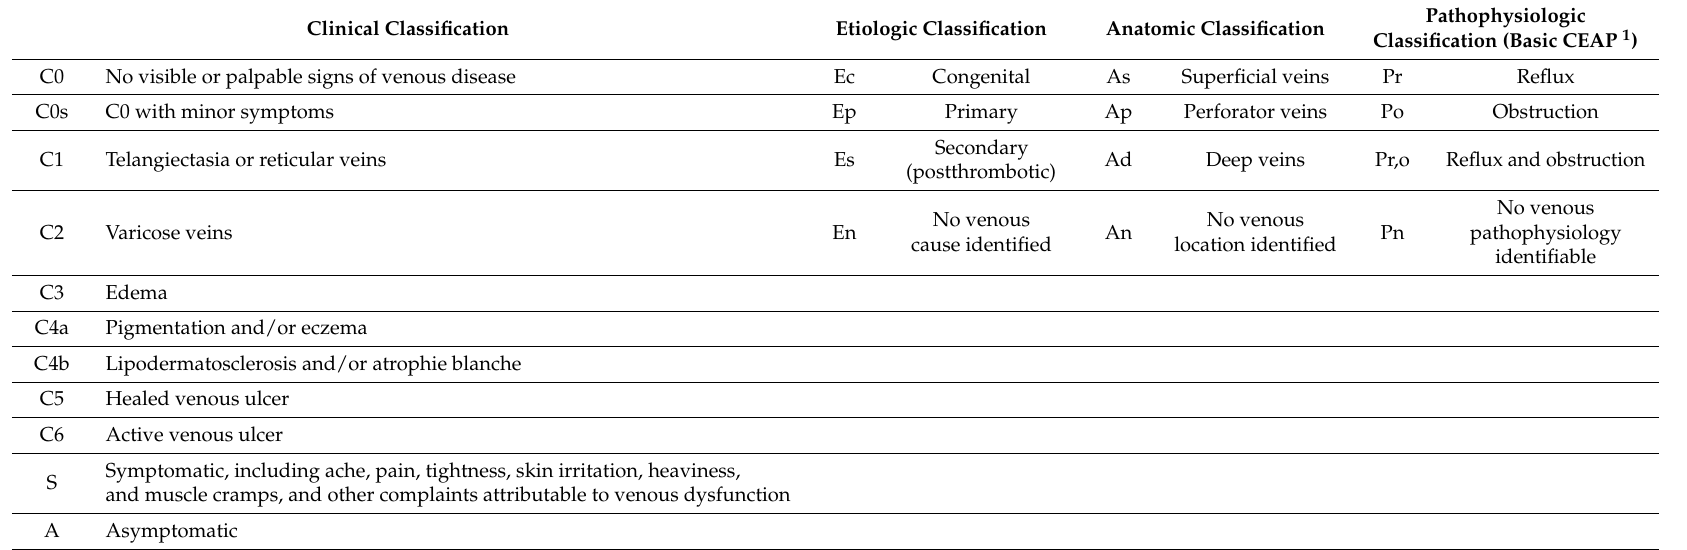
Table 1. Clinical, Etiologic, Anatomic, and Pathophysiologic (CEAP) classifications of